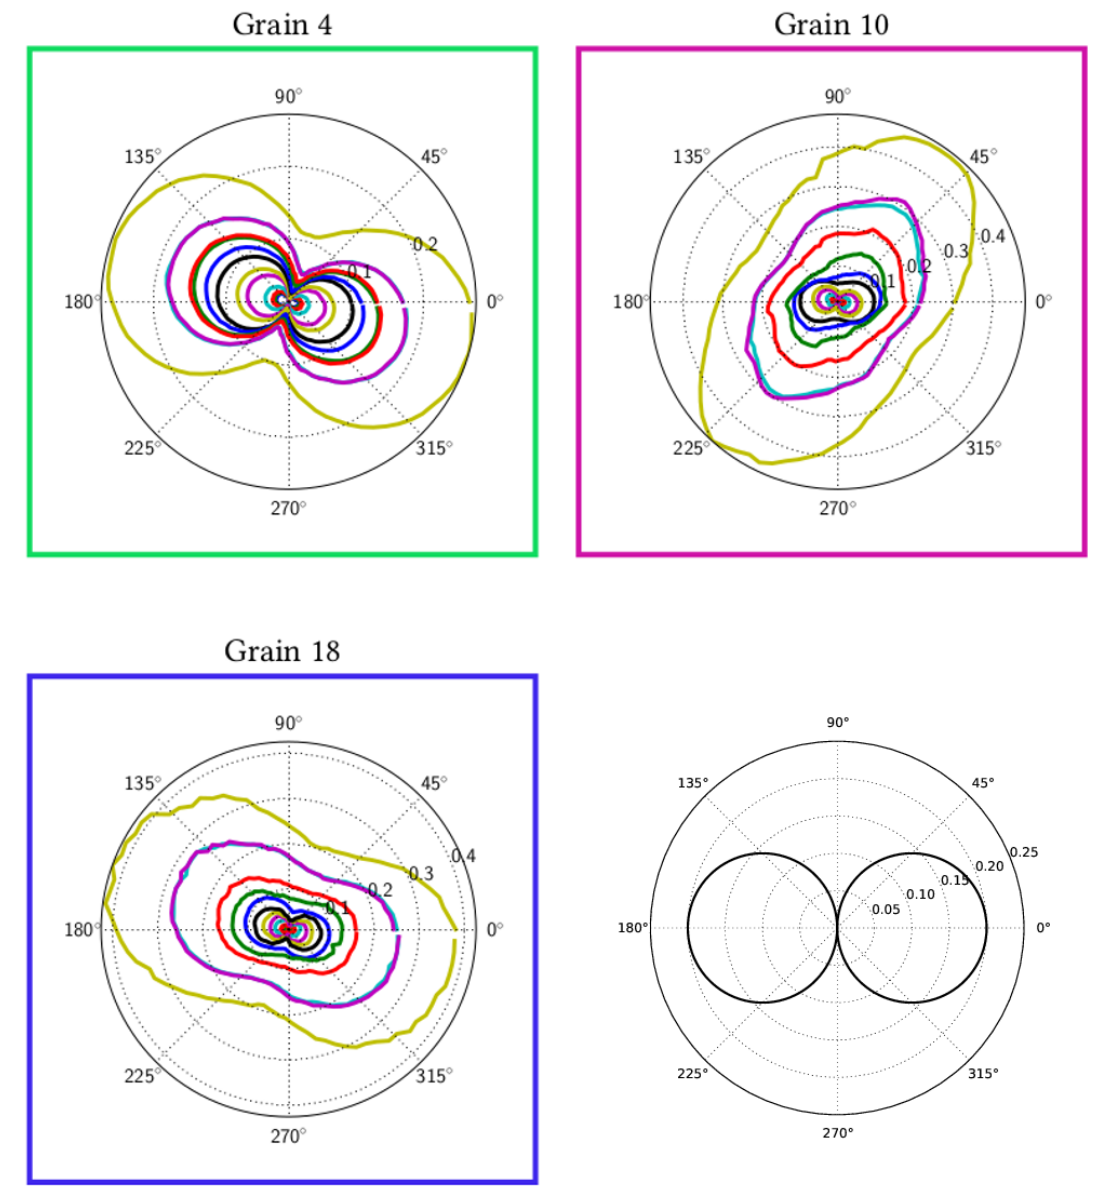
Figure 8. In situ FWEM as a function of ω , for each grain of the cluster (the color code matches the one used for the tensile curve in Figure 2) and example of the FWEM in the case of a crystal ideally bent around a single axis by 0.2 ◦ (bottom